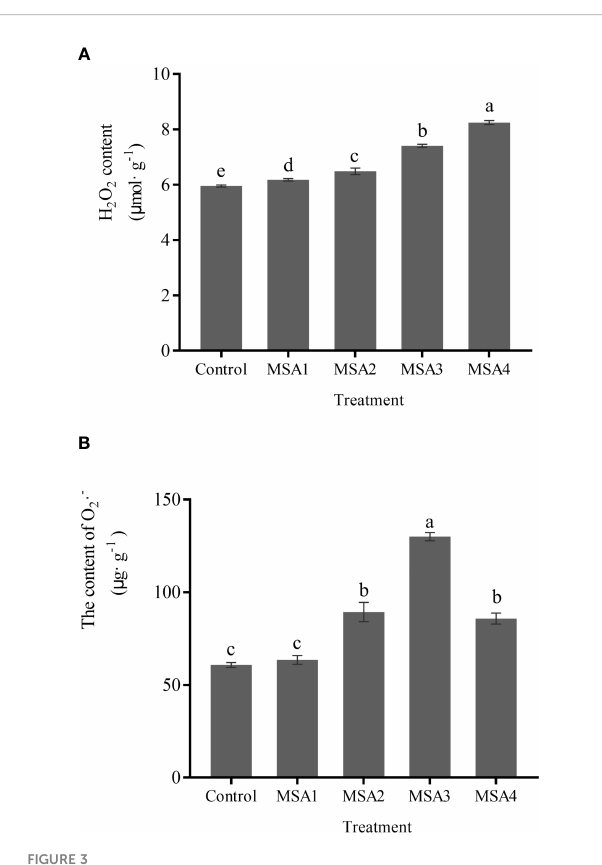
FIGURE 3 Changes in the contents of reactive oxygen species in Trollius chinensis leaves upon saline-alkaline stress. (A) , H O 2· – production